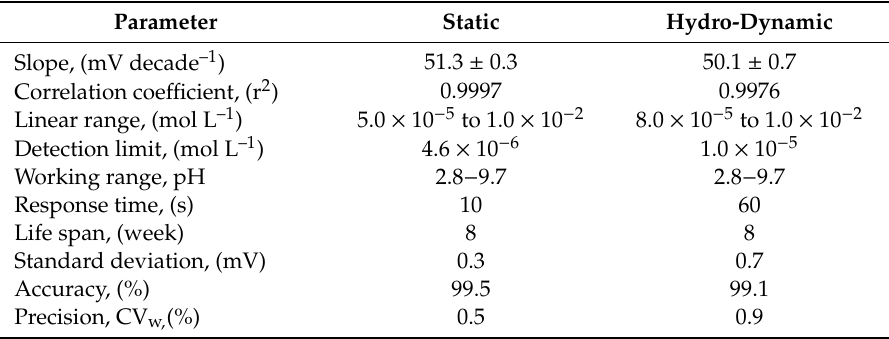
Table 1. Characteristics of DMA sensors under static and flow-through modes of operation in 5 mmol · L –1 Trizma bu ff er, pH